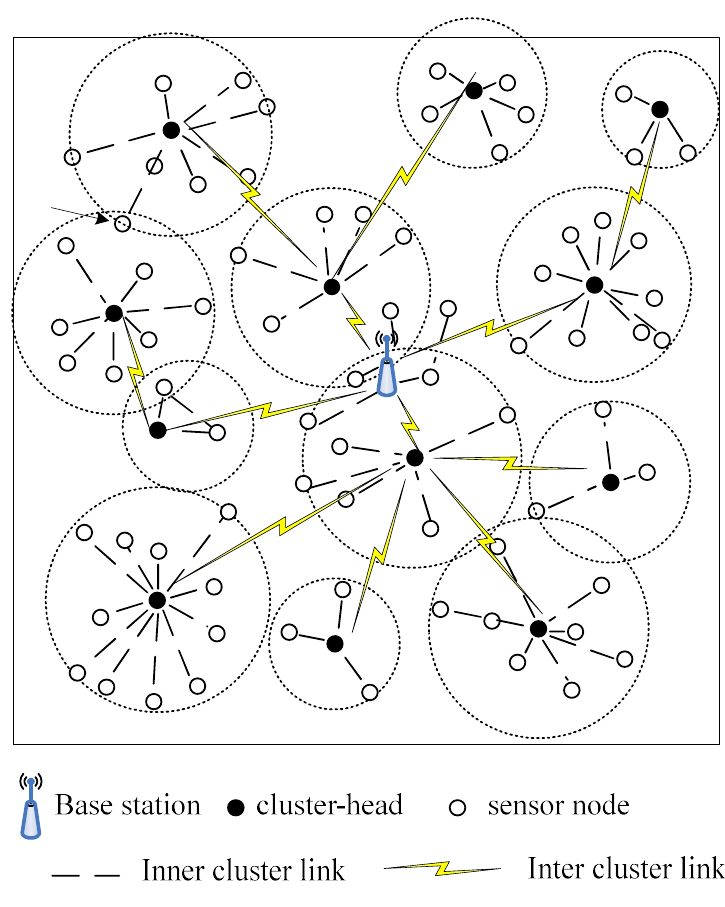
Figure 1. Network architecture of the WSN hybrid routing algorithm.